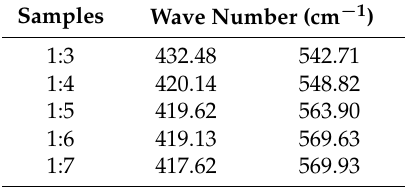
Table 3. Summary of the major vibration modes of BaFe 12 O 19 at different ratios after sintering. Samples